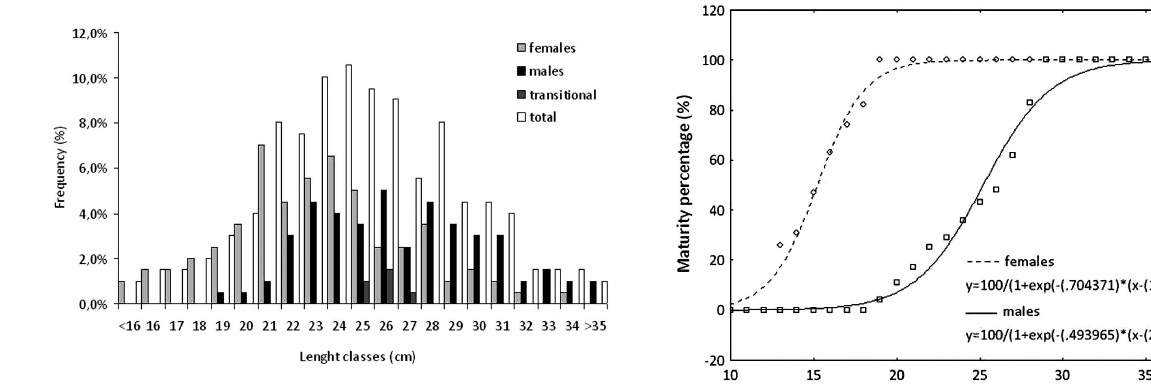
Fig . 2. – Frequency of females, males, transitional and total indi- viduals within size classes of Labrus mixtus.